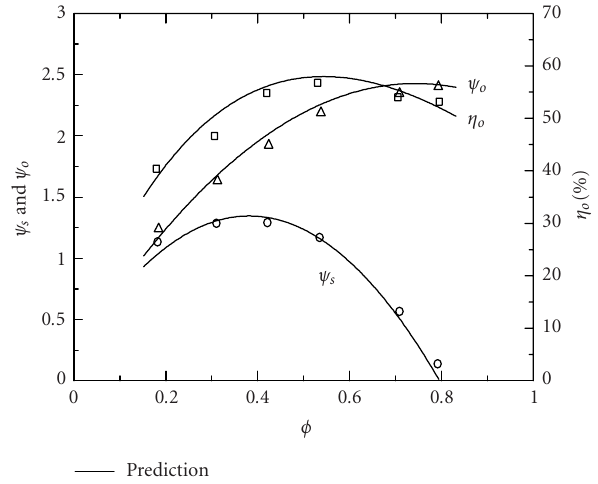
Figure 7: Comparison of calculated and measured performances for a cross-flow fan (Porter and Markland [9]), symbols represent experimental data; 2 250